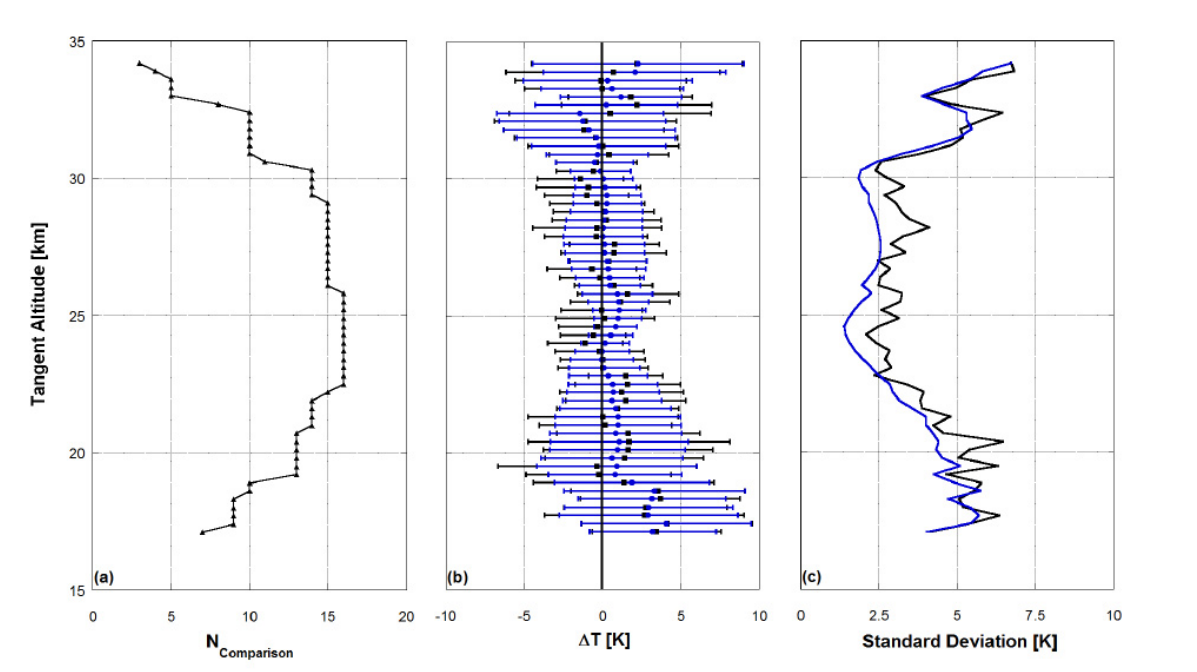
Figure 6. Comparison of the 16 GOMOS temperature profiles. (a) Number of collocated pairs; (b) mean differences between GOMOS and SHADOZ Temperature before (solid black squared dots) and after (solid blue round dots) applying the wavelet analysis. The spread of the average values at each height level, as represented by the standard deviation, is shown by continuous lines. (c) Comparison of the standard deviation of the mean temperature difference at each altitude level for the original (black line) and processed data (blue